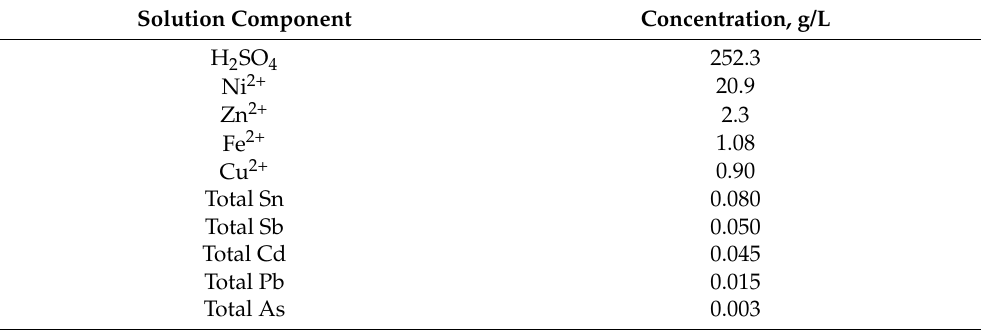
Figure 2. Scheme of DD set-up ( a ) and scheme of electrolyte and water fluxes in the process of DD ( b ). Table 2. The composition of the waste solution *.